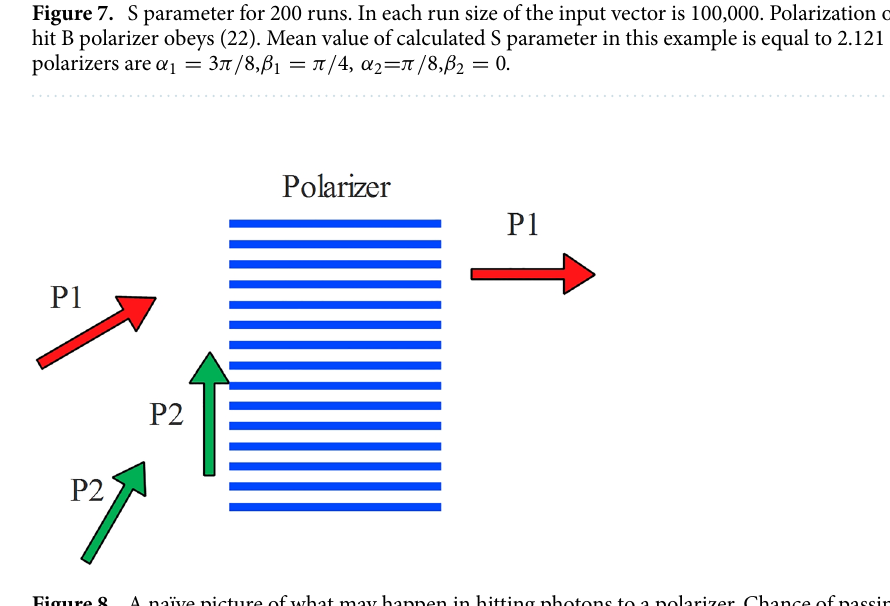
Figure 8. A naïve picture of what may happen in hitting photons to a polarizer. Chance of passing a photon through a polarizer is higher if its angle of polarization is closer to the polarization angle of the polarizer (Malus’ law). After passing a photon its polarization will change to the polarizer angle. If it doesn’t pass, its polarization (at the very end, before absorption) will change to the perpendicular to the polarization angle of the